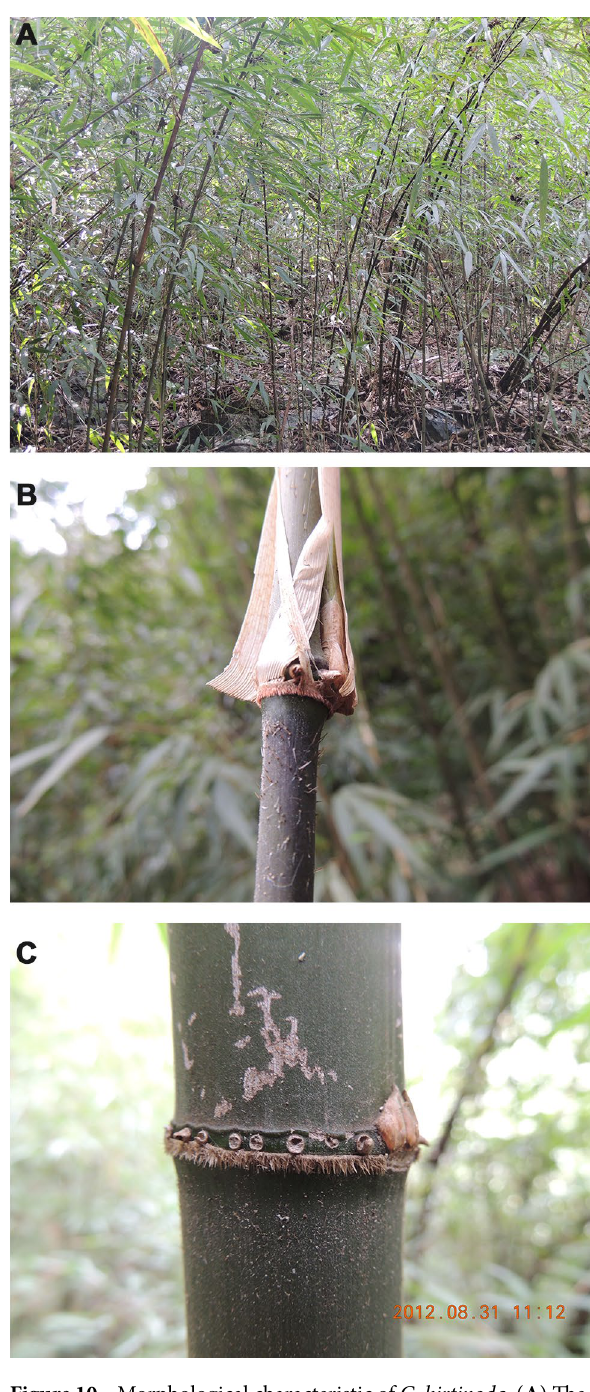
Figure 10. Morphological characteristic of C. hirtinoda . ( A ) The wild habitat of C. hirtinoda ; ( B ) nodal ridges; ( C ) rings of root